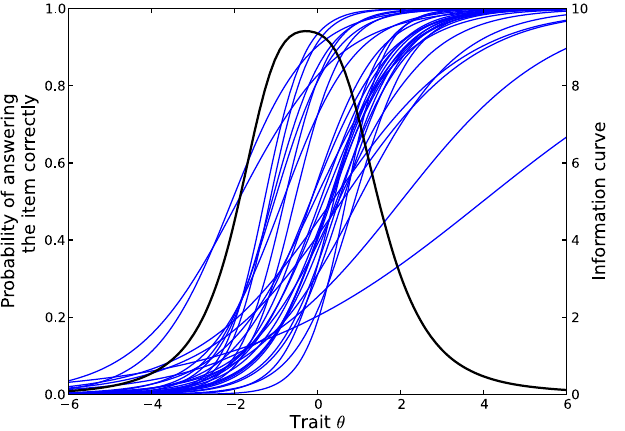
FIG. 3 (color online). The item characteristic curves shown for a single-trait two-parameter model for all 30 items. It is apparent that the − 3 ≤ θ ≤ 3 is well covered by items, and also there are at least two items (question 15 and 26) which poll the students with higher skills. These two items correspond to the two rightmost curves in this graph. The overall test information curve has also been depicted with a heavier line and with its scale denoted on the right vertical axis.